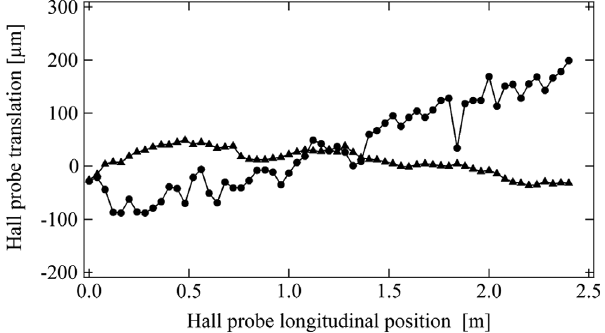
FIG. 10. Hall probe translation versus longitudinal position. (Filled circle) Translation in the vertical z axis direction, (triangle) translation in the horizontal x axis